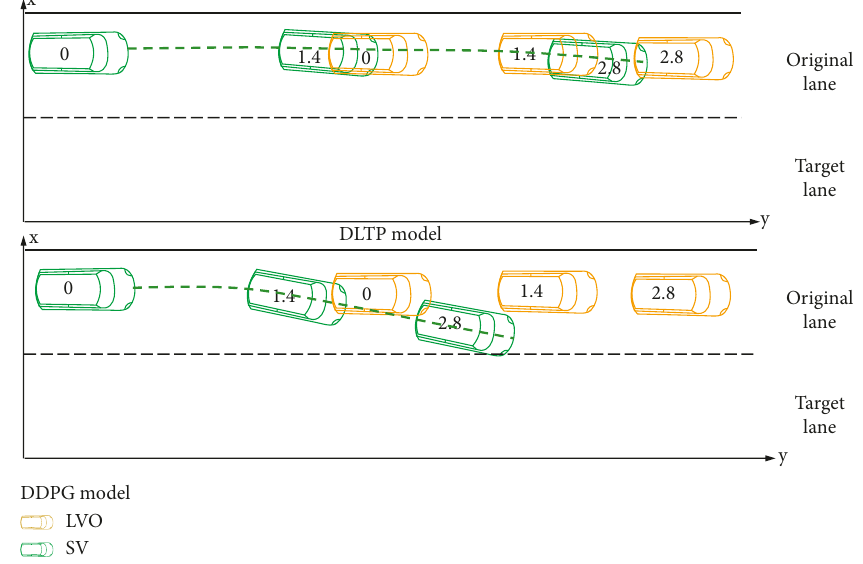
Figure 15: Comparison between the DLTP model and the DDPG model.